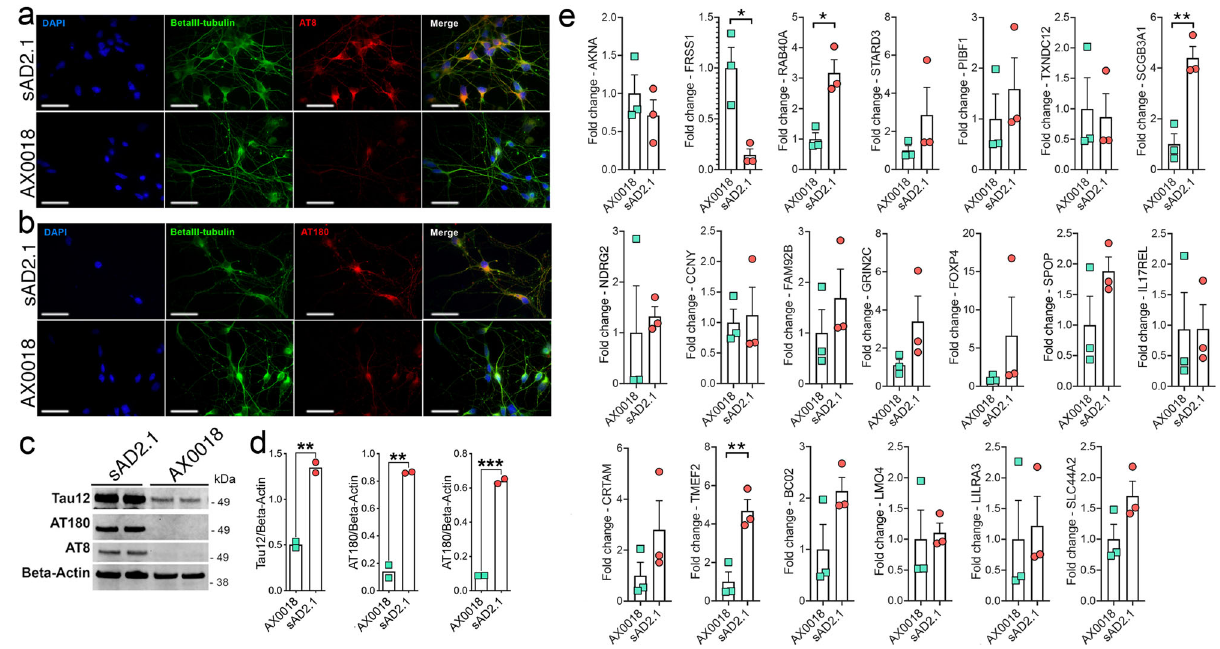
Fig. 3 mRNA for four of predicted genes are altered in human sAD2.1 iPSNs compared to control AX0018 iPSNs. a , b . Quantitative immunocytochemistry showing signi fi cant increase of pS199/pS202 (AT8) tau in β III-tubulin (neuronal marker) positive sAD2.1 iPSNs compared to control AX0018 iPSNs. Scale bar: 20 μ m. c , d . Western blot and quanti fi cation showing signi fi cantly increased levels of total, pS199/pS202 (AT8), and pT231 (AT180) positive tau levels in sAD2.1 iPSNs compared to control AX0018 iPSNs. (Raw blots are shown in Supplementary Fig. 9). e . Quantitative real-time PCR analysis showing two folds increase in the mRNA levels of RAB40A p value = 0.0232, SCGB3A1 = 0.0053, TMEFF2 = 0.0096, and a fold decrease in FRRS1 = 0.0431 in sAD2.1 iPSNs compared to AX0018 control iPSNs. Data shown are mean ± s.e.m; Two-tailed t tests welch-corrected; * p <0.05; ** p <0.01, *** p <0.005, n = 3 biological replicates; n = 3 technical